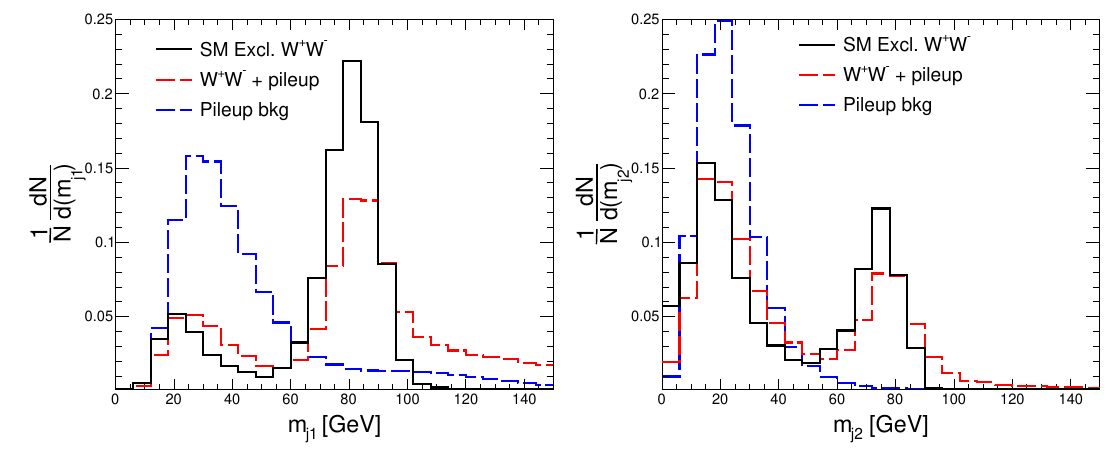
Figure 2 . Large-radius jet invariant mass distribution for the leading (left) and subleading (right) in mass in the hadronic channel. The distributions are normalized to unity. The SM exclusive W + W − pair production is displayed in black full line, the pileup background in blue dashed line (after preselection requirements), and the pileup background subcomponent of W + W − +pileup is shown in red. The peak at around 80 GeV corresponds to the W boson rest mass. The peak at lower masses corresponds to cases where only one of the quarks of the W boson decay is tagged as a jet in the final state, or more generally for light-flavor quark jets or gluon